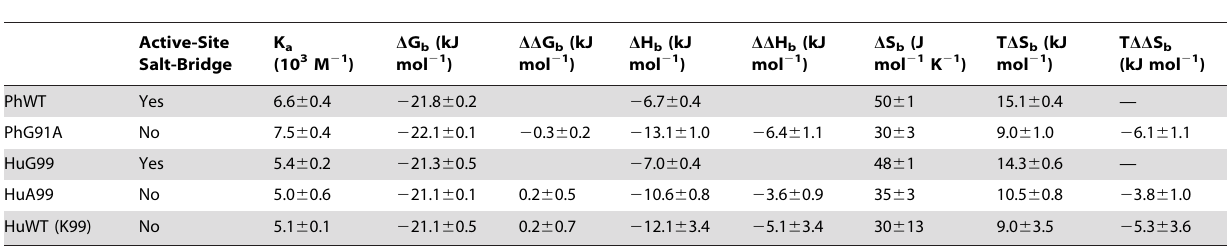
Table 2. Thermodynamics parameters for binding of substrate-analogue determined by isothermal titration calorimetry.